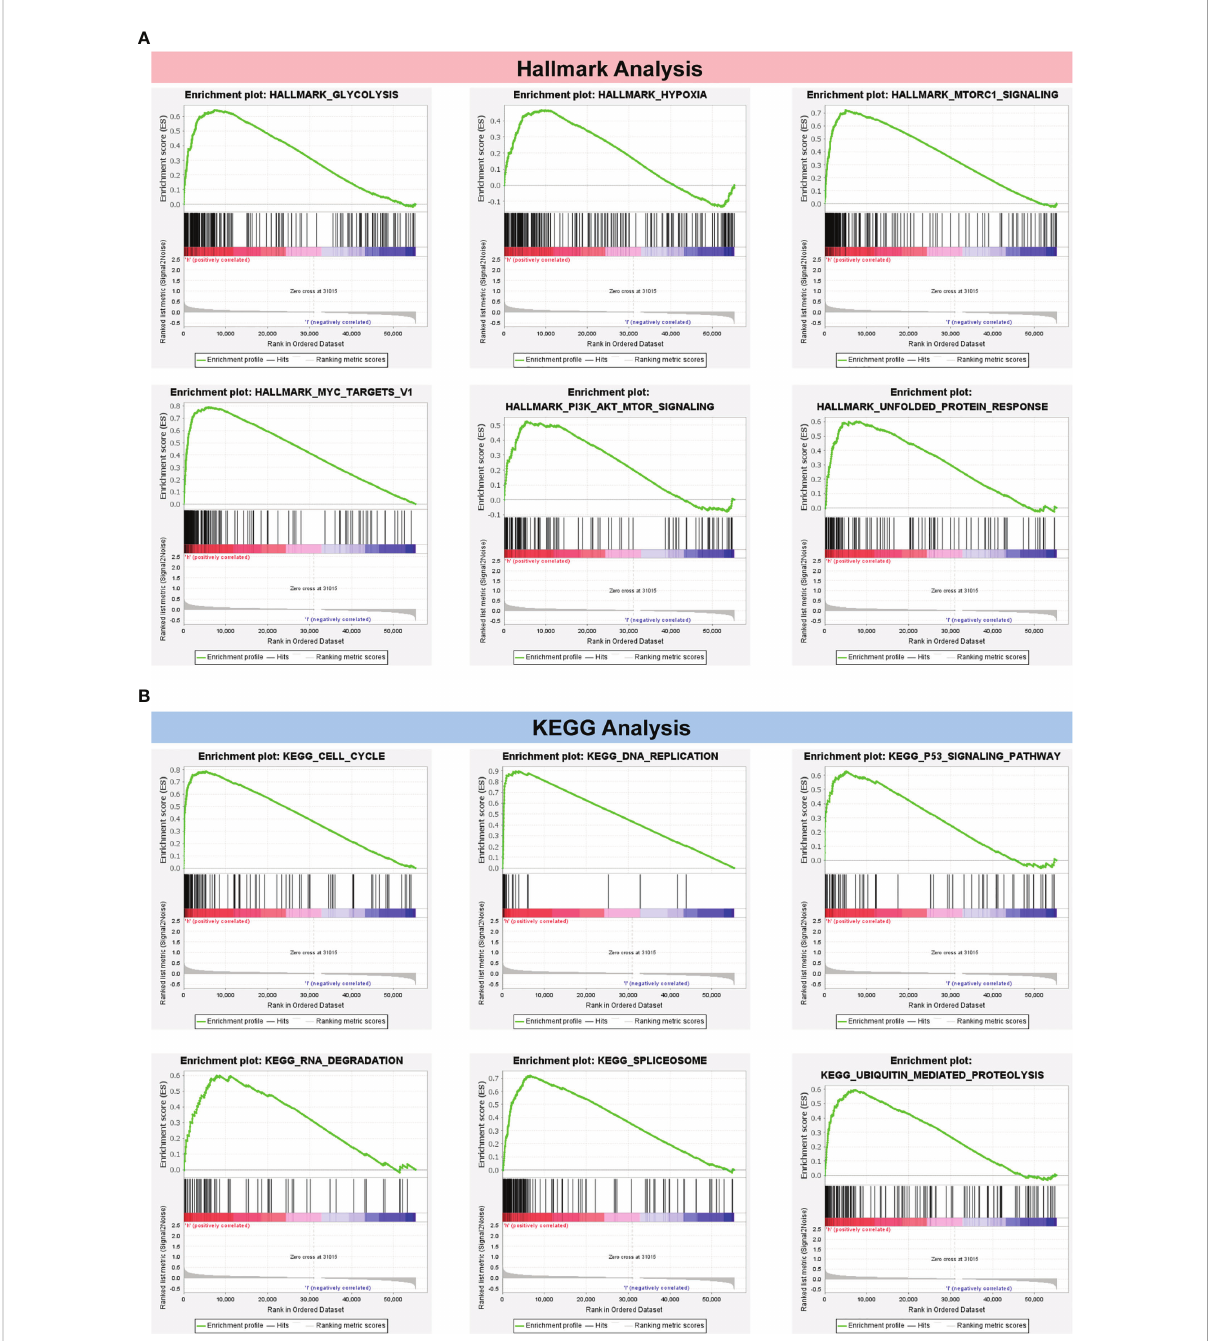
FIGURE 7 Gene Set Enrichment Analysis. (A) Hallmark analysis of the CRBS. (B) KEGG analysis of the